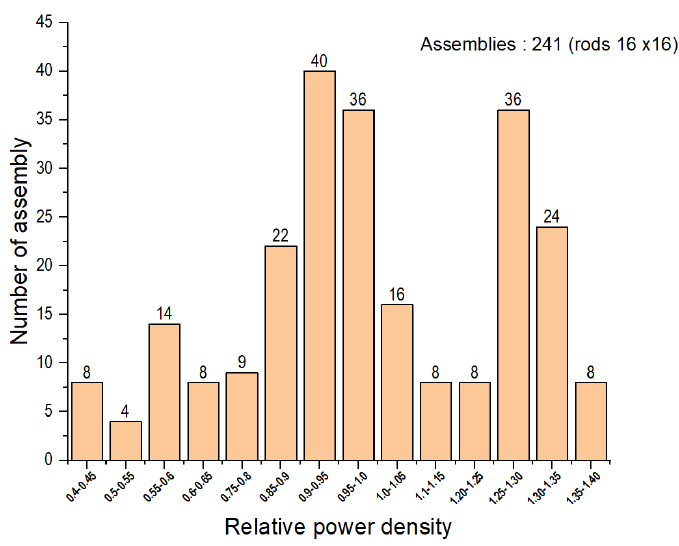
Figure 9. The number of assemblies according to the relative power